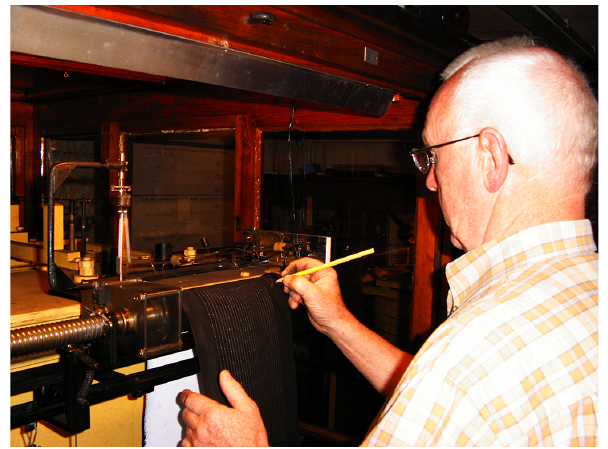
Figure 8. Removing the (second last) smoked paper from the seis- mographs on 16 June 2005. Photo: Holger Ste ff